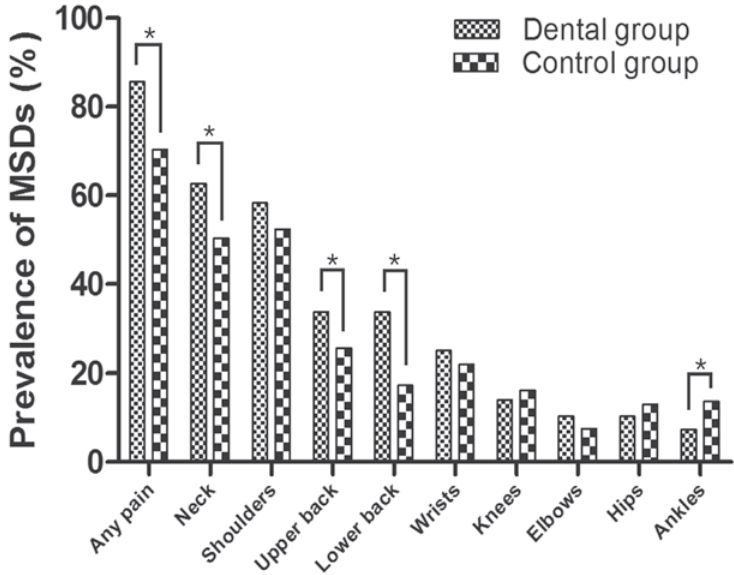
Figure 1- Musculoskeletal disorders (MSDs) prevalence at various anatomical regions in the dental and non-dental postgraduate groups. MSDs prevalence is calculated as the ratio of positive MSDs (ED+LW+LM+LY) number to the total number * P